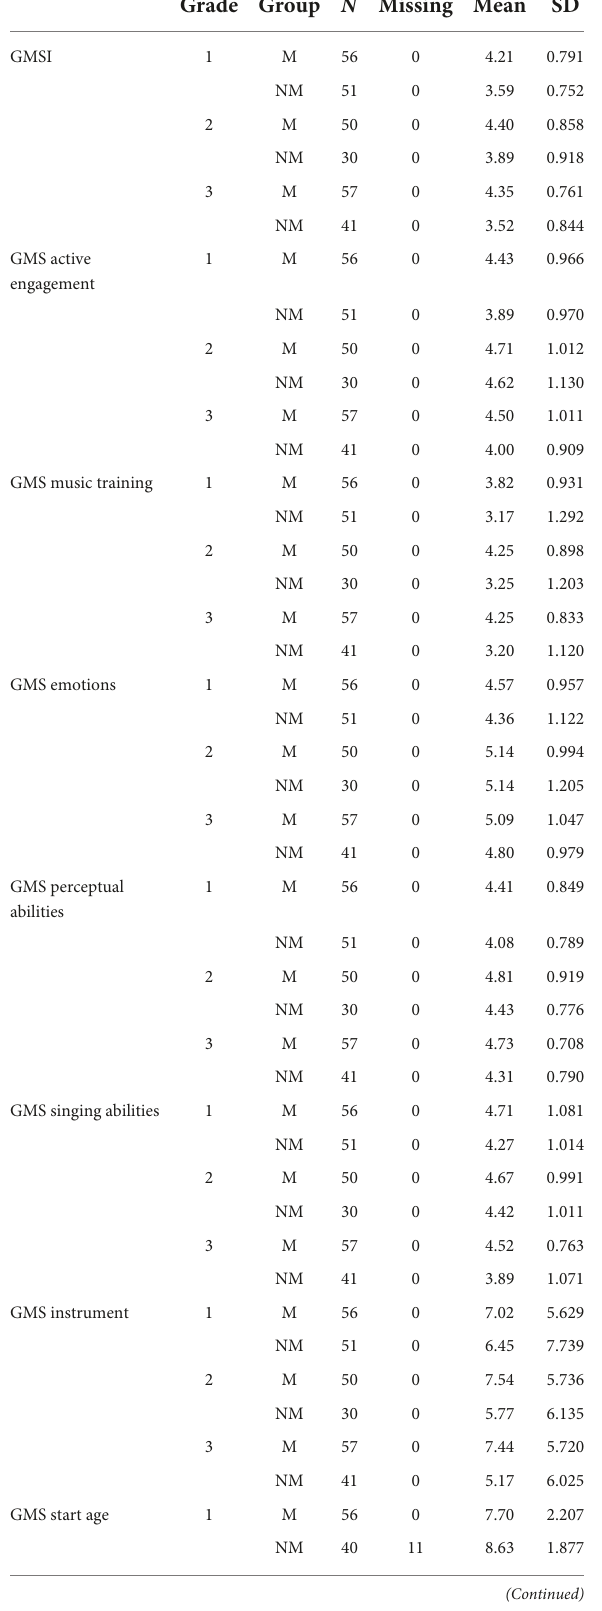
TABLE 5 Gold-MSI descriptives for all